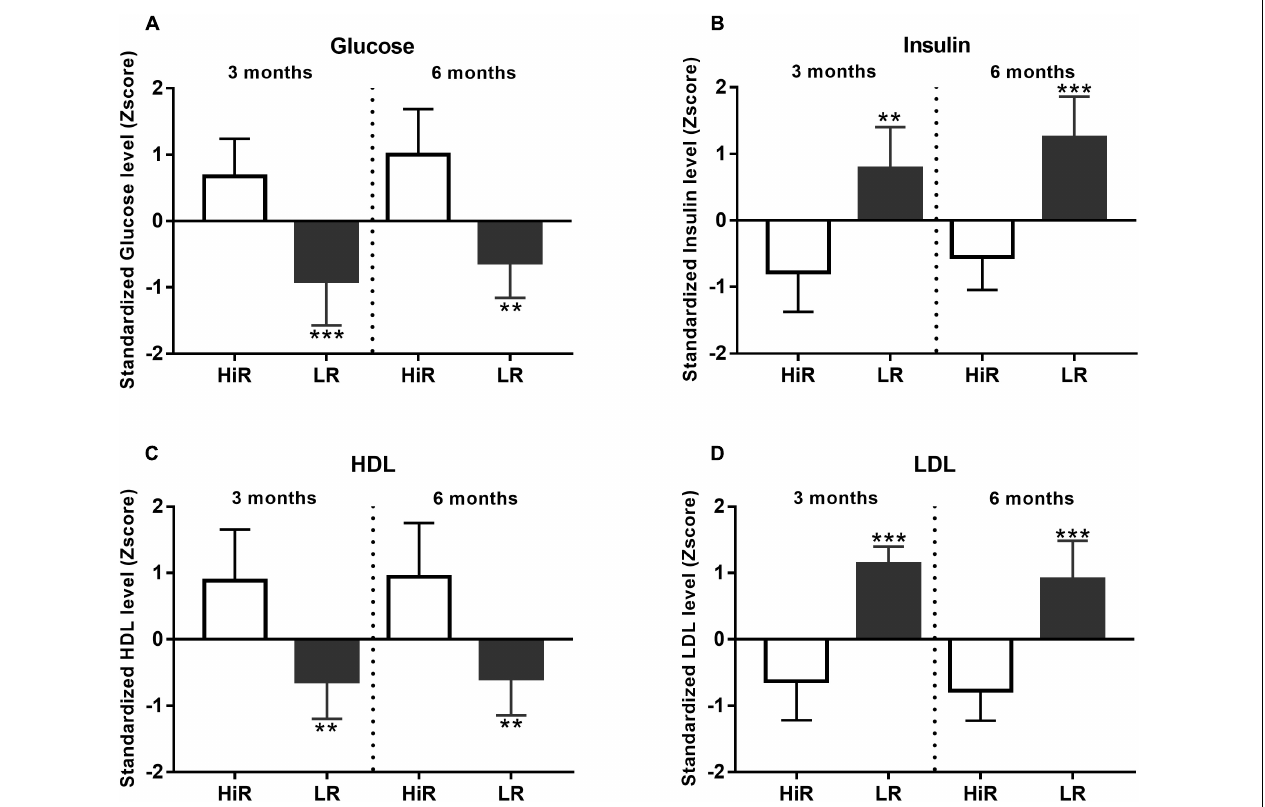
FIGURE 2 | Individual variation of metabolic parameters in response to lifestyle program. (A–D) K-means cluster analysis was used to differentiate high- (HR) and low (LR) responders ( n = 14). Bar graph values indicate standardized Z-score values, and standard deviation values. 3- and 6-month values were normalized to baseline values and converted to Z-scores. ∗ Significant difference between HR and LR ( p < 0.05). ∗∗ Significant difference between HR and LR ( p < 0.01). ∗∗∗ Significant difference between HR and LR ( p < 0.001). Please refer to Supplementary Material S1 for exact numerical